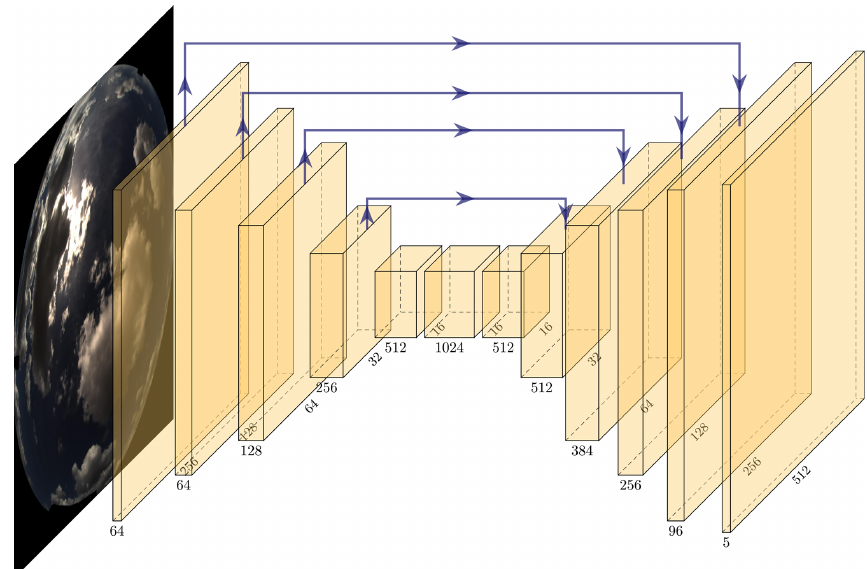
Figure 3. Simplified graph of U-Net architecture for segmentation with ResNet34 backbone.